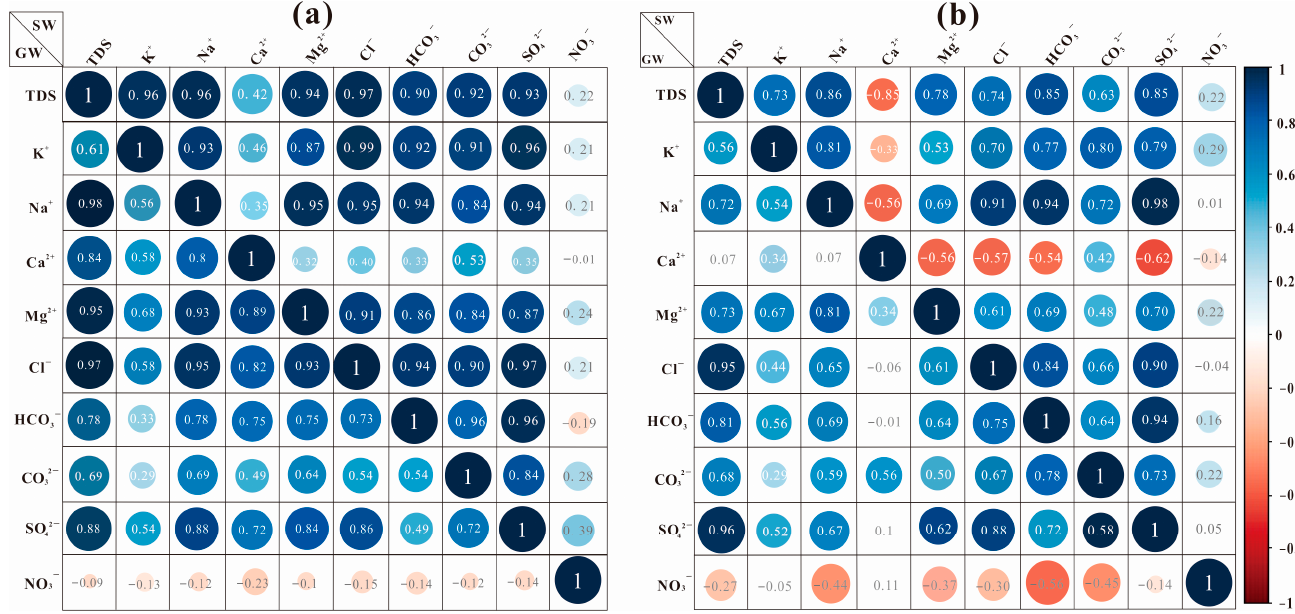
Figure 4. Correlation of the major ions between lake water and groundwater during the different seasons: ( a ) non-frozen season; ( b ) frozen season.